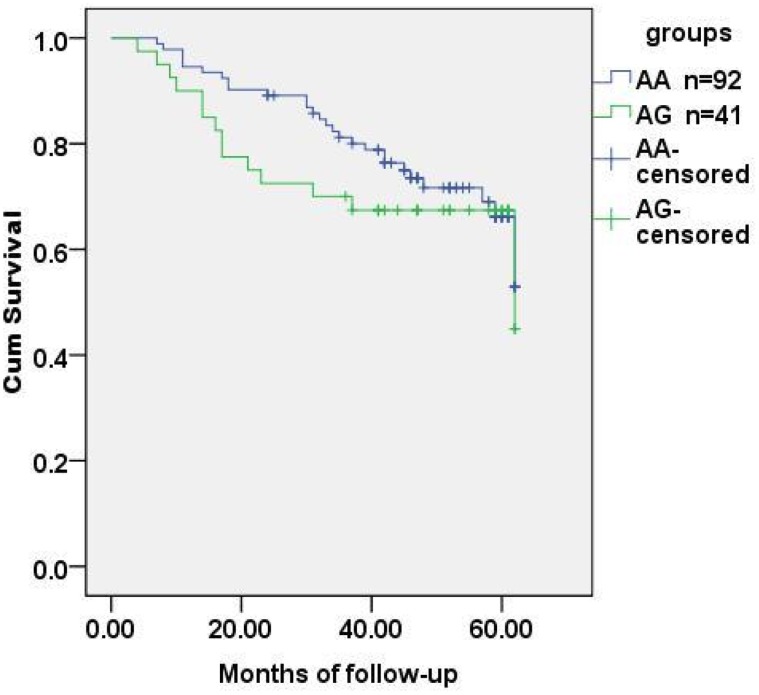
Tumor-free survival analysis of CRC patients stratified by rs8176746 genotypes.With rs8176746 (chr-9 ABO), the disease-free time of CRC patients grouped by allelic genotypes (AA and AG) was not significantly different (p = 0.366). Subjects with genotype GG were excluded (n = 2).